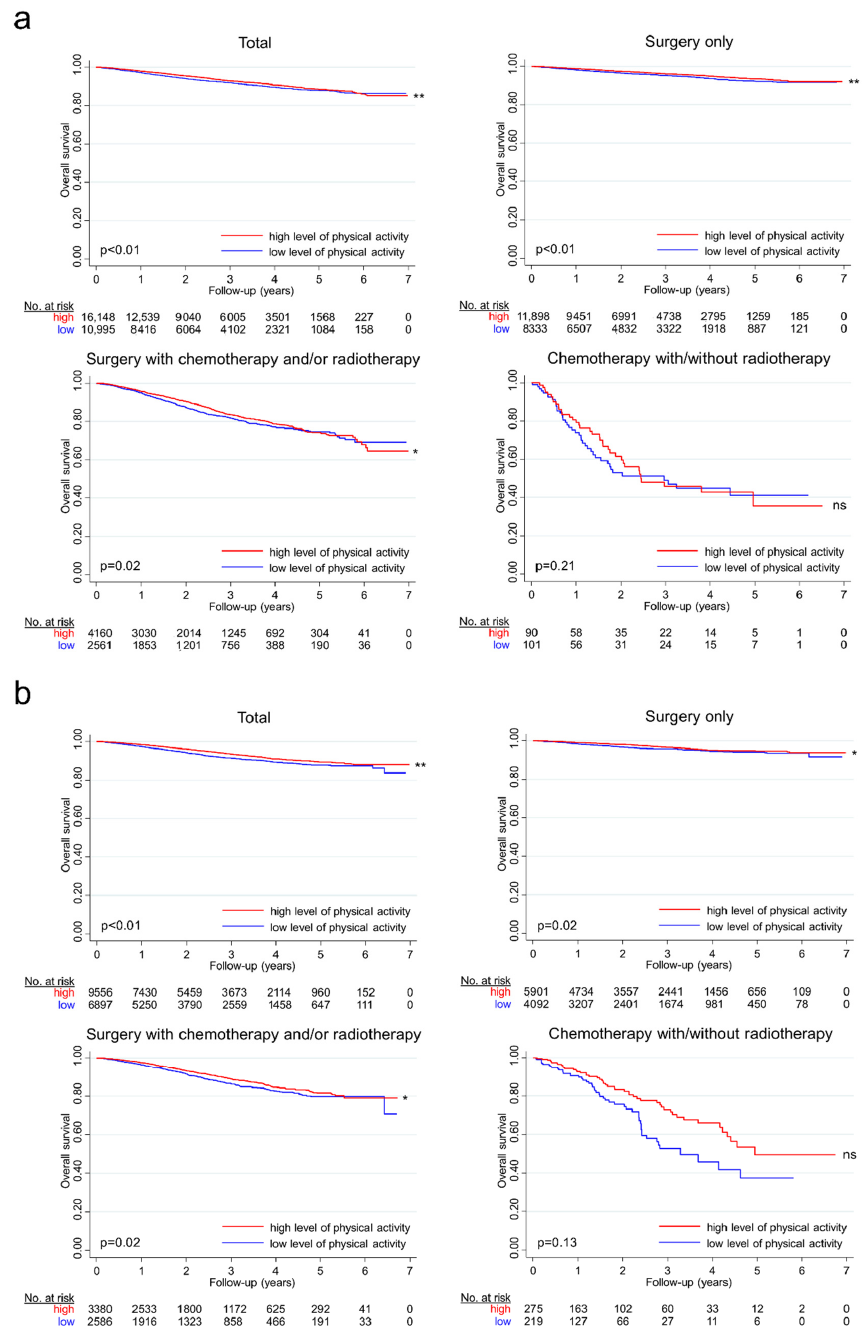
Figure 2. Kaplan–Meier survival curves as stratified by physical activity groups for colon and rectal cancer. Kaplan–Meier survival curves for colon cancer patients ( a ) and rectal cancer patients ( b ), stratified by the following treatment groups: total, surgery only, surgery with chemotherapy and/or radiotherapy, and chemotherapy with or without radiotherapy. The red line represents the survival probability of patients with a high level of activity (the weighted sum of the frequencies for walking, moderate, and vigorous activity greater than or equal to three times/week), and the blue line represents the survival probability of patients with a low level of activity. **, *, and ns next to graphs indicate p -values lower than 0.01, p -values lower than 0.05, and nonsignificant results, respectively. The results indicate that satisfying the recommended level of activity is associated with a lowered risk of mortality in colorectal cancer patients, particularly in patients who received surgery with or without other treatment options such as chemotherapy or